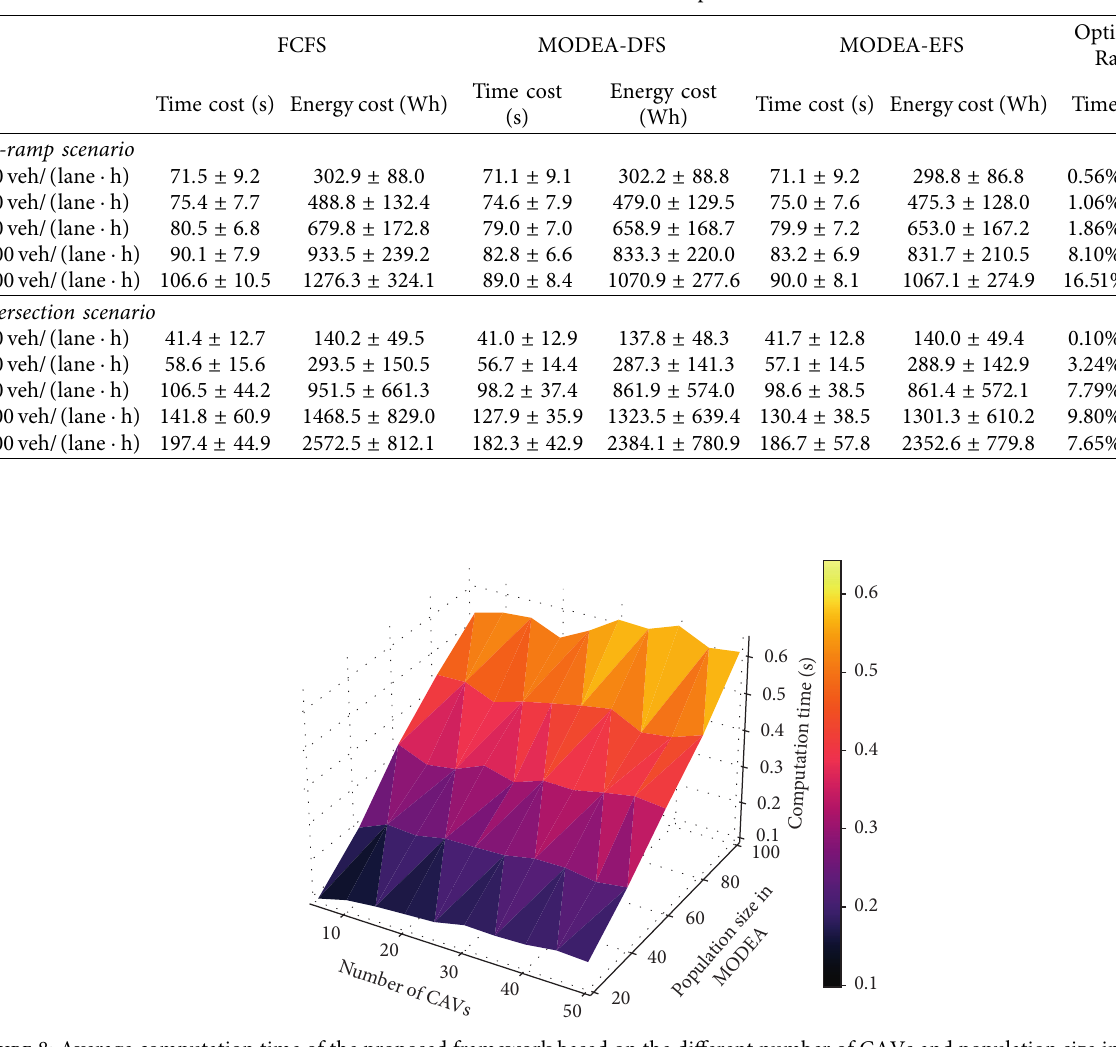
Figure 8: Average computation time of the proposed framework based on the different number of CAVs and population size in